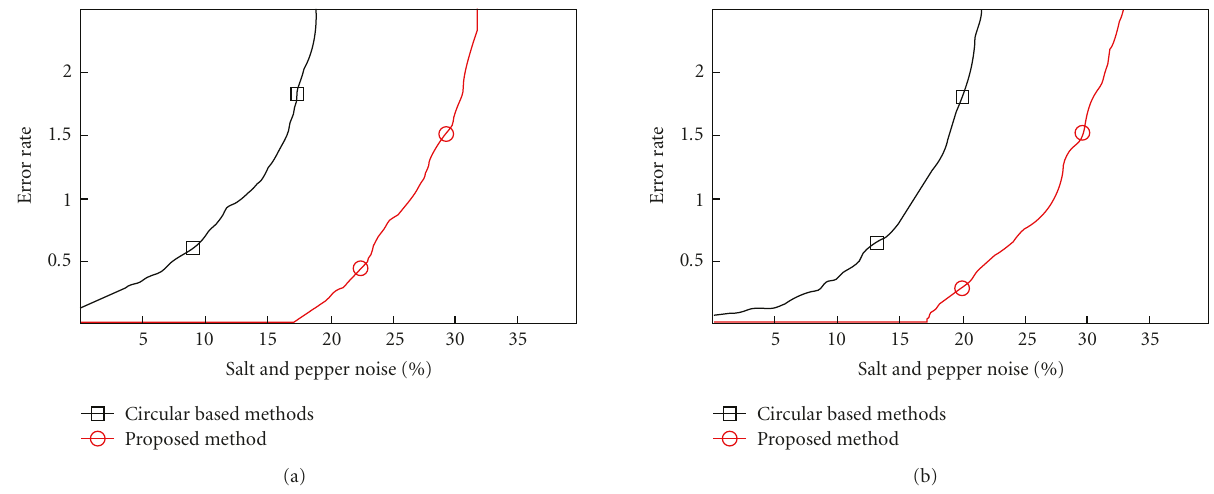
Figure 13: Error comparison between circle-based method and proposed method in noisy situation (salt and pepper noise).